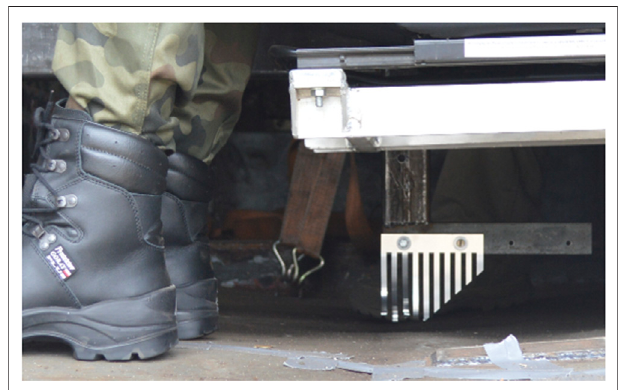
FIGURE 1 | Elastic deformation of the fl oor (4 cm) recorded with a measuringcombaftertheexplosionofa1.7-kgTNTchargeunderthevehicle.